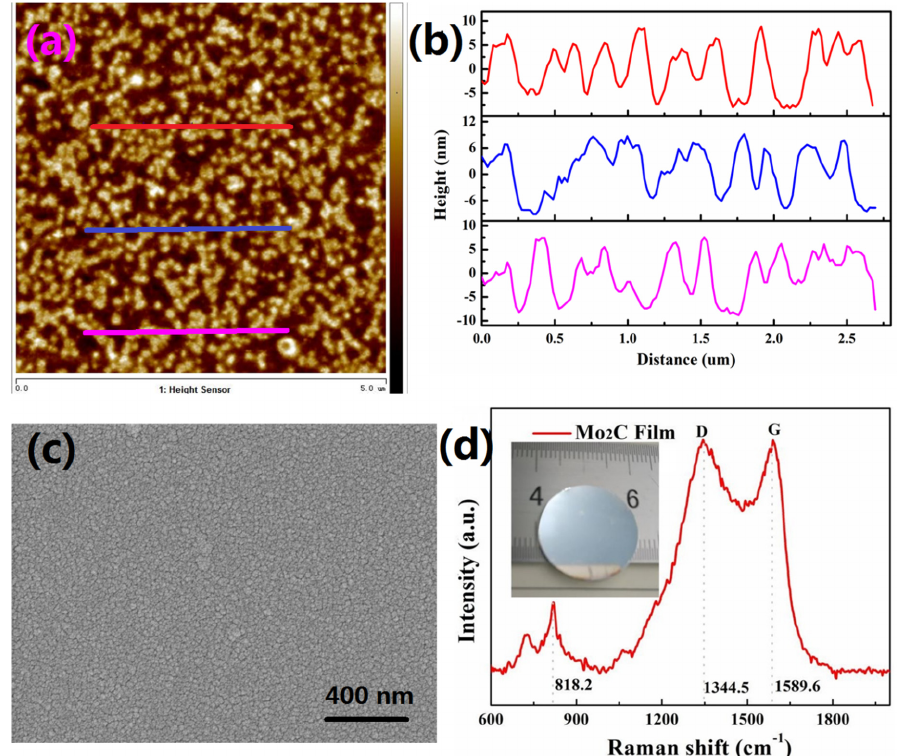
Figure 1. ( a ) Atomic force microscope (AFM) of Mo 2 C films are 2D topographical images, ( b ) their corresponding thickness profiles, ( c ) scanning electron microscopy (SEM) of Mo 2 C, and ( d ) Raman spectra of Mo 2 C film.